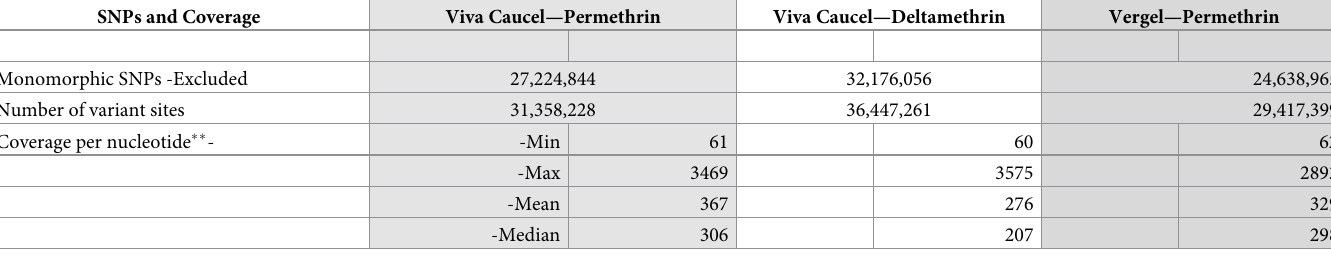
Table 2. Polymorphisms and